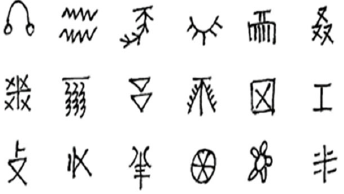
Figure 2. Image obtained via the manual handwriting method. Table 1. Comparison of sample size before and after handwriting amplification in some categories.